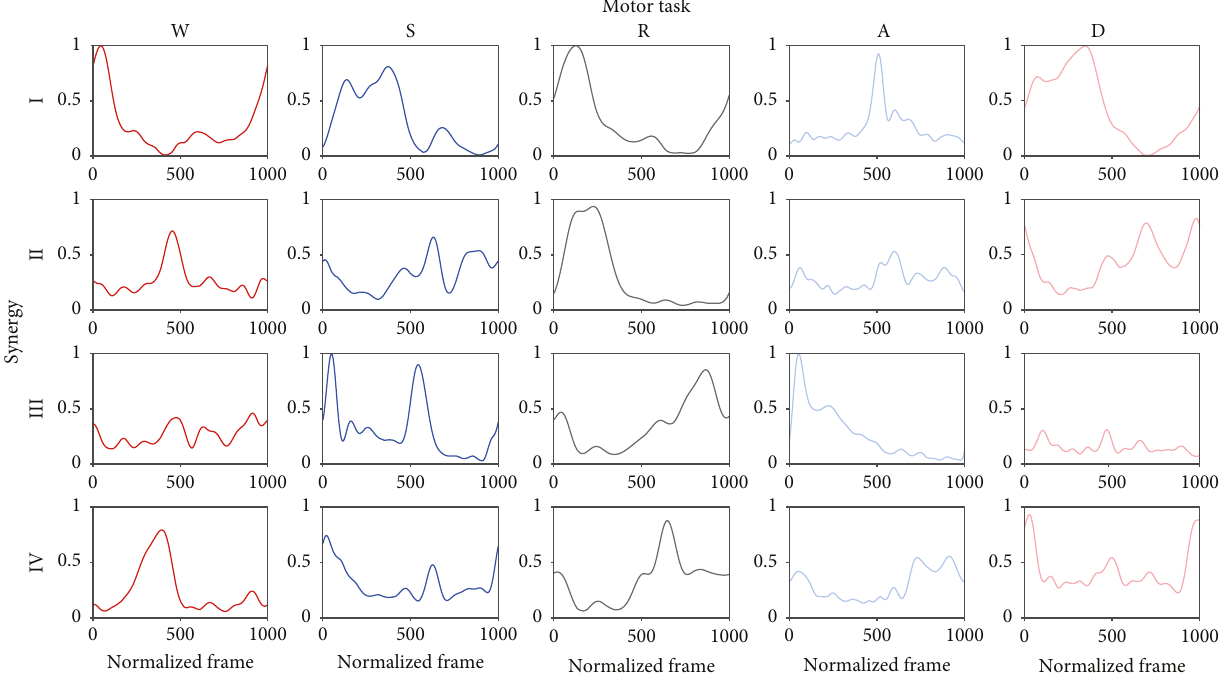
Figure 7: Mean value of the temporal activity pattern in the 4-synergy model related to each daily life activities. The mean has been obtained by averaging across subjects the temporal activity pattern mean of the three sessions of each subject. For visualization purposes, temporal activity patterns are normalized to unity. Table 9: Mean value and standard deviation (SD) of B VAF in